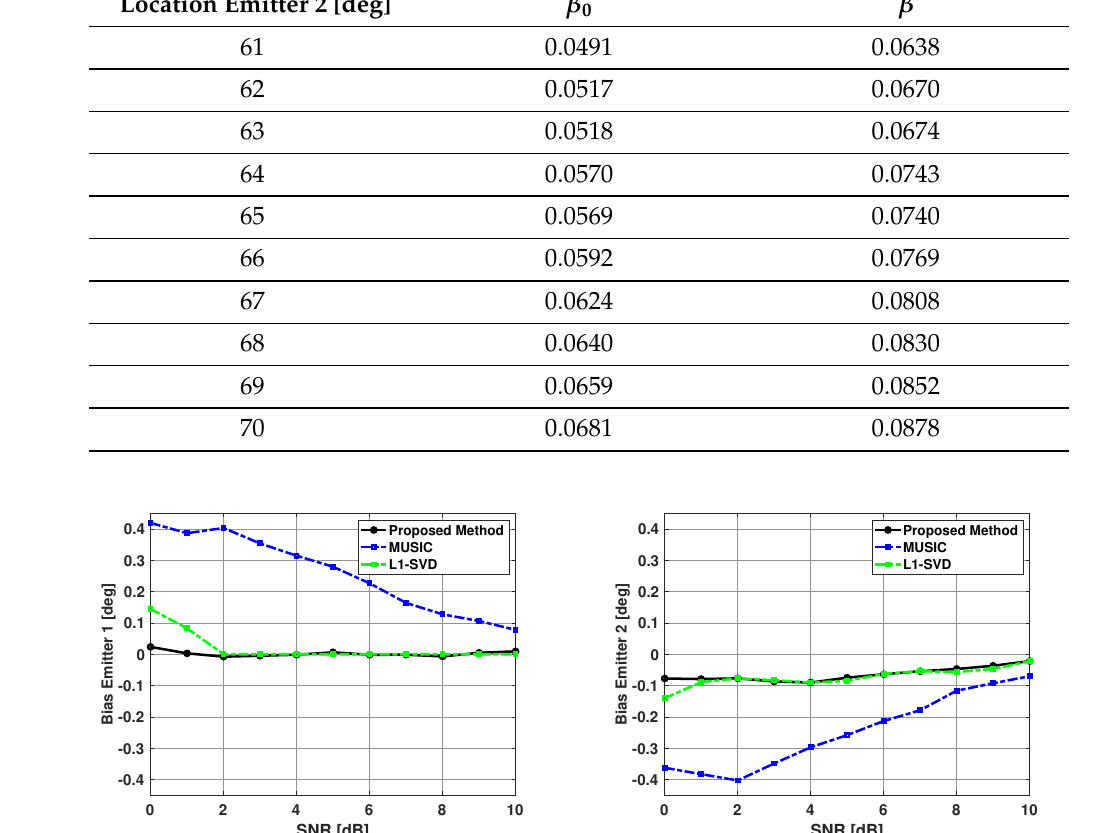
Figure 12. Biases in the estimated direction of the two emitters versus SNR: Proposed Method, MUSIC Algorithm, and L1-SVD Algorithm, Emitters at 60 and 63 deg, 100 snapshots, 500 trials.